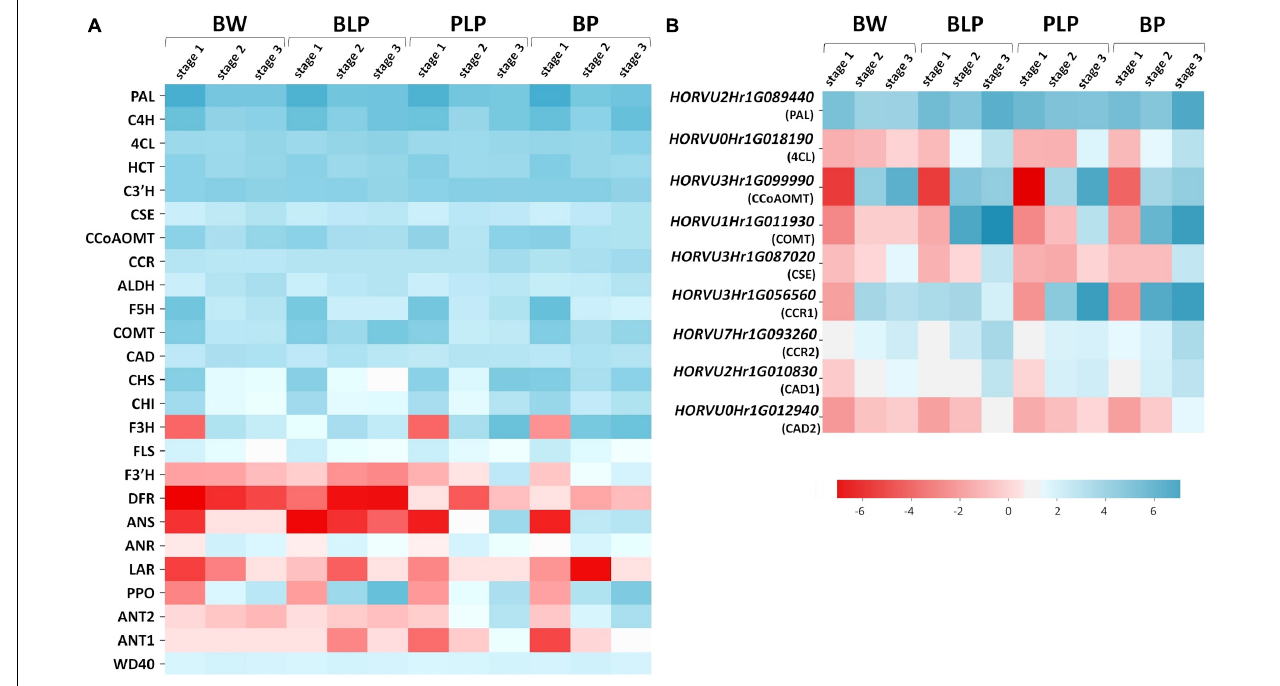
FIGURE 5 | Heatmap analysis of mean expression levels of the key genes of phenylpropanoid biosynthesis (A) and the genes with line-specific expression (B) in lines Bowman (BW), BLP, PLP, and BP at the three stages of spike development.